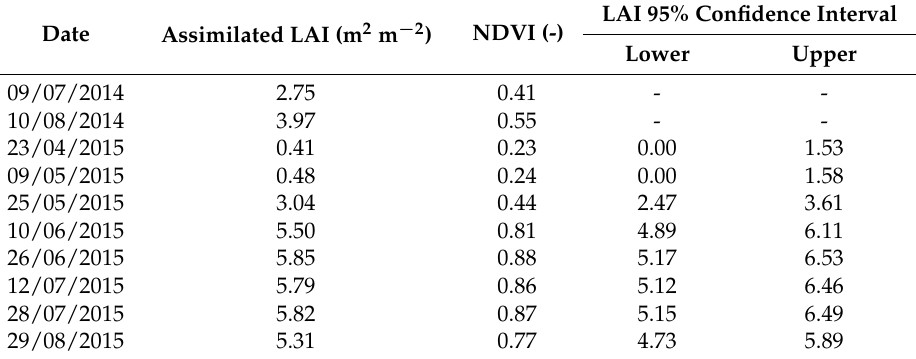
Table 5. Leaf Area Index (LAI) assimilation